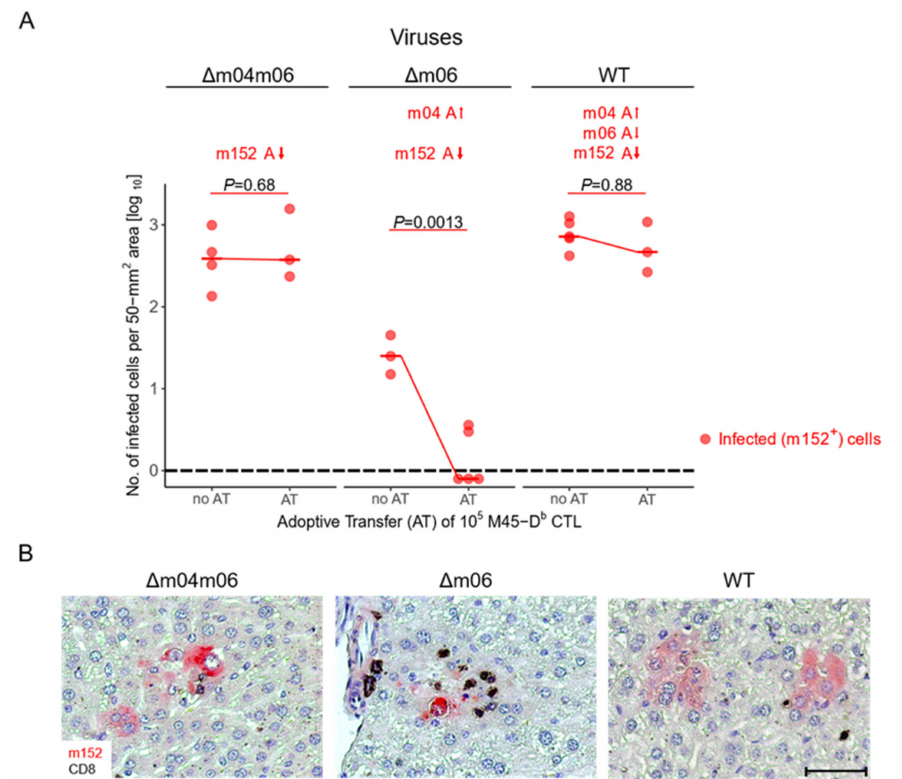
Figure 4. ( A ) Adoptive transfer of M45-D b CTL into immunocompromised C57BL/6 mice infected with viruses mCMV- ∆ m04m06, selectively expressing vRAP m152, mCMV- ∆ m06 expressing vRAPs m152 and m04, as well as wild-type (WT) mCMV expressing vRAPs m152, m04, and m06. Data represent infected m152 + cells present in 50-mm 2 areas of liver tissue sections. The red dot symbol represents mice tested individually. Median values are marked and connected for comparison. (A-arrow up or down), positive or negative effect on antigen presentation, respectively; (AT) adoptive transfer. P values for comparing groups with or without AT were calculated by a Student’s t -test with Welch’s correction for unequal variances. Differences are considered significant for P < 0.05. The dashed line represents the detection limit of the assay. Note that the lower viral load in the “no AT” group of infection with mCMV- ∆ m06 does not reflect virus attenuation but results from a lower initial dose of infection. Reproduced from [32] in a new arrangement. ( B ) Representative images of liver tissue sections stained by 2-color immunohistochemistry and hematoxylin counter-staining. (Red) Infected liver cells, mostly hepatocytes, identified by a cytoplasmic expression of m152 that is shared by all three viruses; (Black) Tissue-infiltrating CD8 + T cells. Bar marker: 50 µ m. Reproduced from reference [32] in a new marker